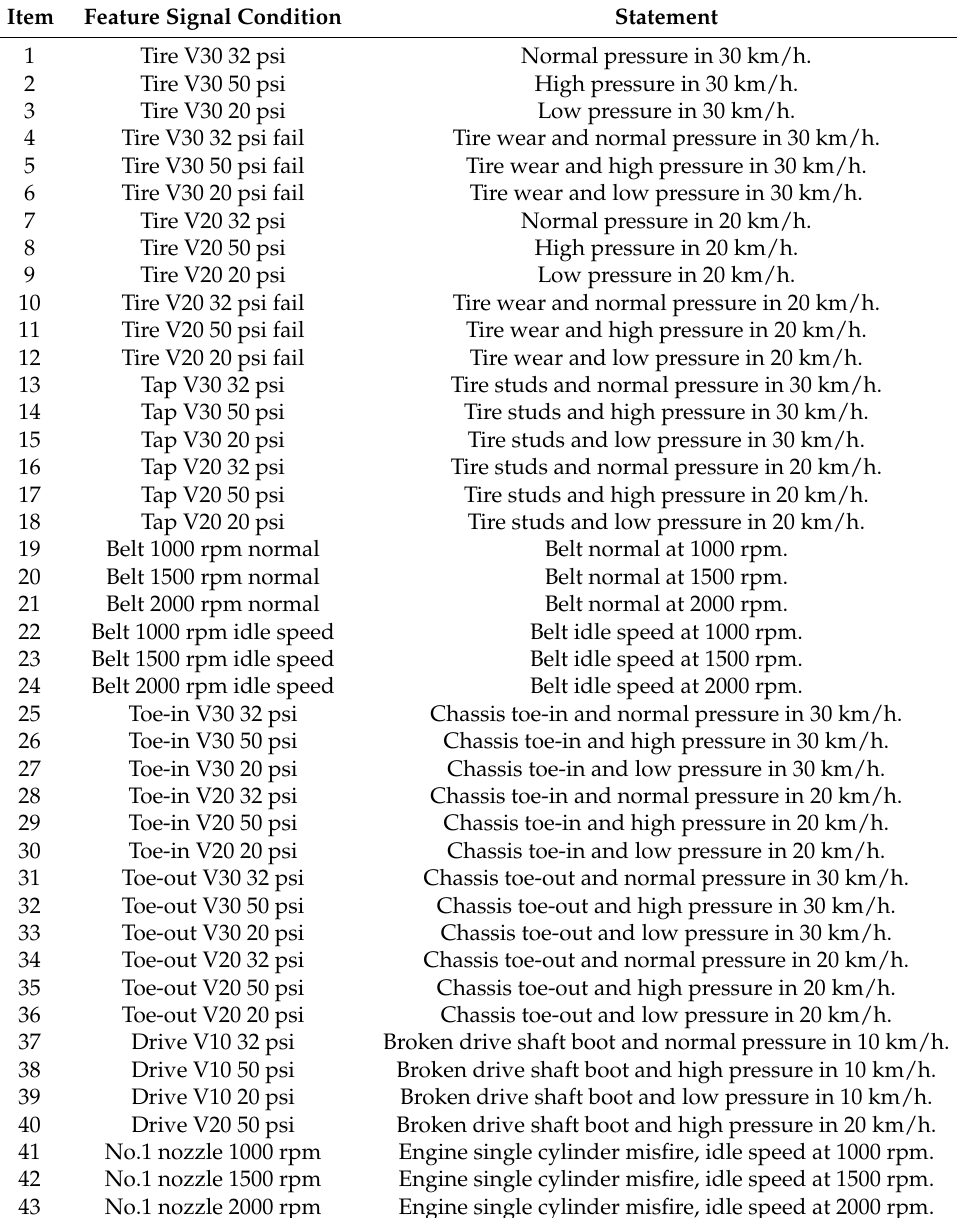
Table 1. The definition of 43 driving fault signals (engine, tire, and